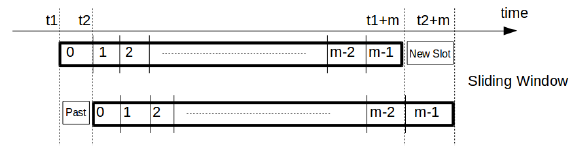
Figure 4. Sliding